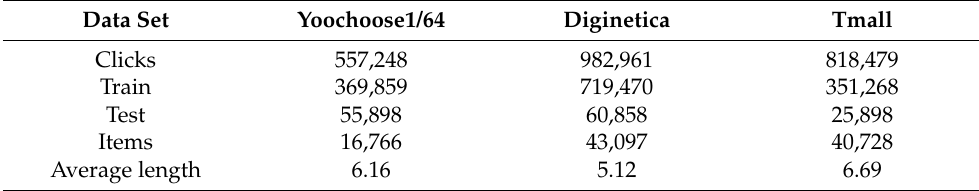
Table 1. Statistics data for the data